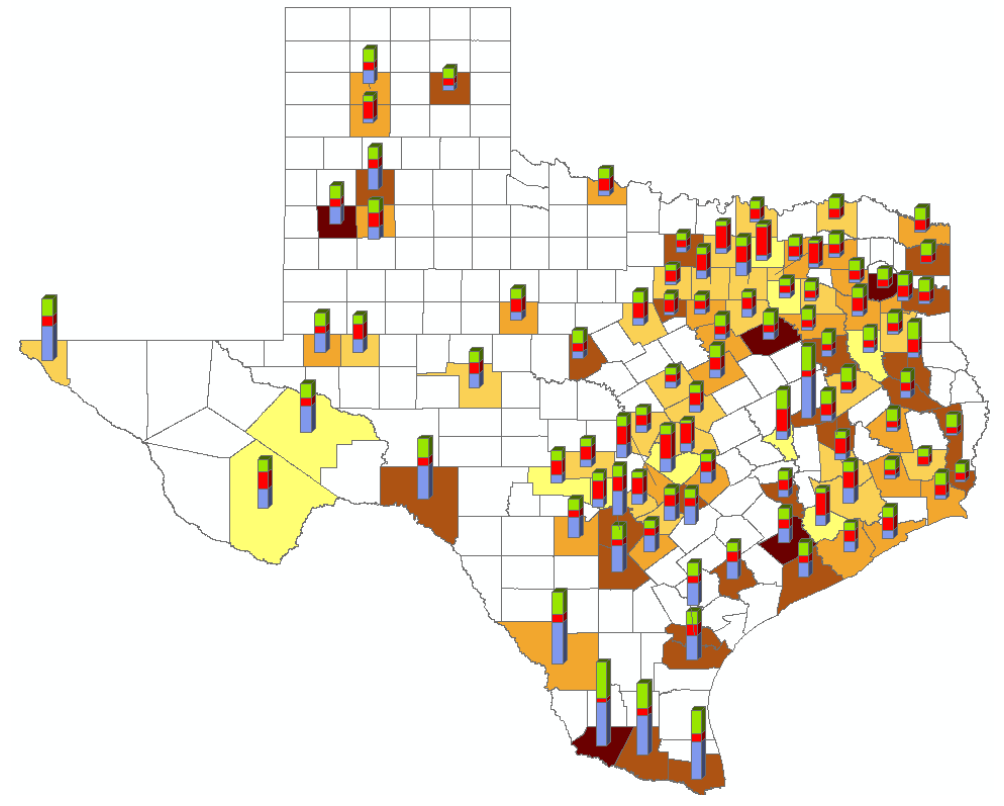
Figure 1. Texas Counties Showing the Association of Percentage of Obesity, Hispanic Population, Poverty, and Graduation with Bachelors or